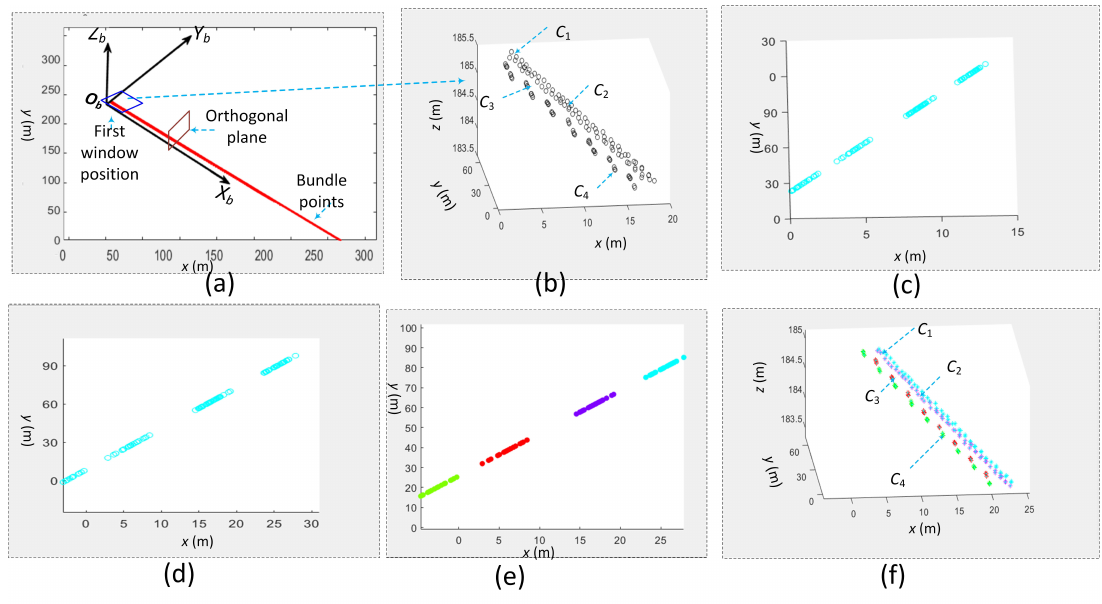
Figure 5. Subconductor extraction using a sliding window: ( a ) local coordinate system, sliding window, and orthogonal plane; ( b ) Conductor points within the first window position; ( c ) 3D view of projected points on orthogonal plane; ( d ) 2D view of projected points on orthogonal plane; ( e ) 2D view of projected point clusters on orthogonal plane; ( f ) individual conductor points (clusters) in different colors. In panels ( a , b , f ) the origin (0, 0) represents (5.1436 × 10 5 , 6.9226 × 10 6 ) and in panels ( c – e ) the origin (0, 0) represents (5.14398 × 10 5 , 6.9247 × 10 6